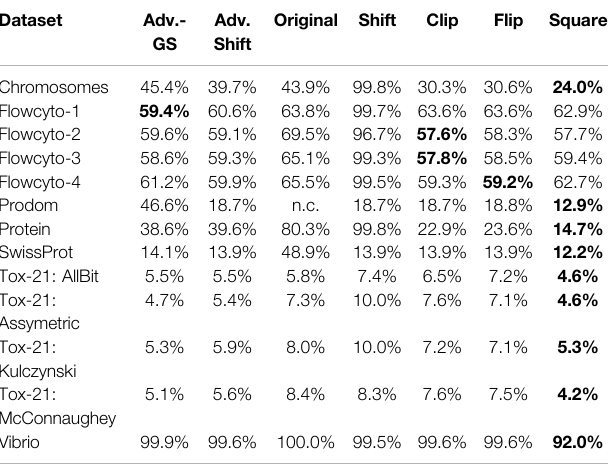
TABLE4| AveragepercentageofdatapointsthatareneededbytheSVMmodels for building a well- fi tting decision hyperplane.